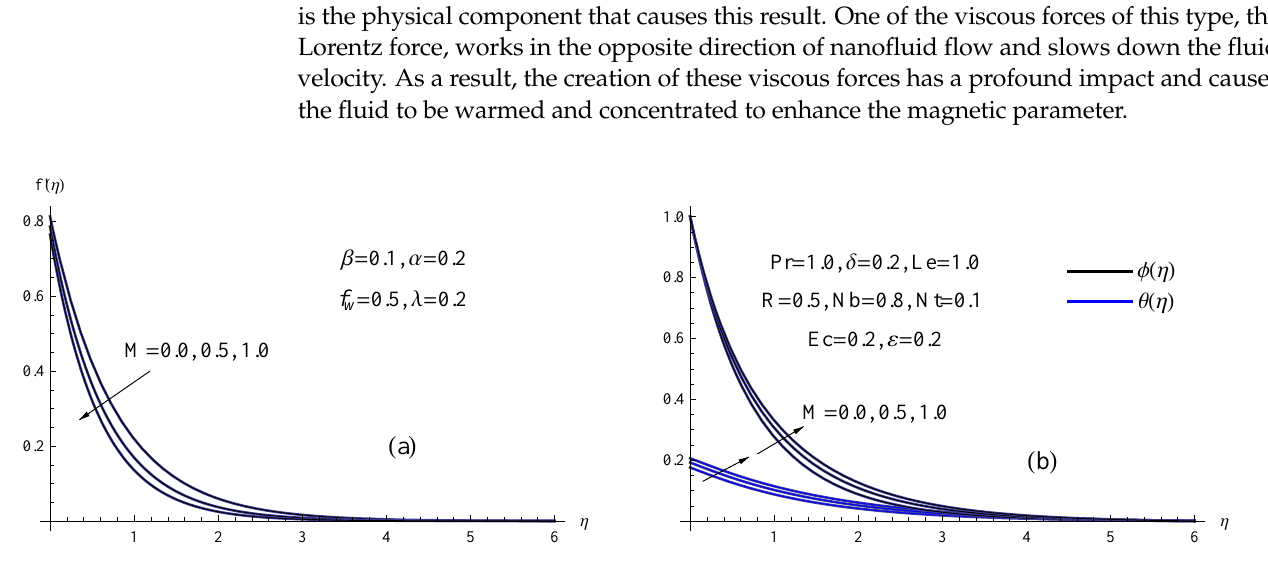
Figure 4. ( a ) The f (cid:48) ( η ) for chosen M , ( b ) θ ( η ) and φ ( η ) for chosen M . For various values of the viscosity parameter α , Figure 5 explains the demeanor of the velocity f (cid:48) ( η ) , temperature θ ( η ) and concentration φ ( η ) fields. The graphic shows that as the viscosity parameter climbs, the momentum boundary layer thickness and velocity field slow down. The essential duty of nanofluid viscosity, which mostly depends on temperature, is to promote mass and heat transfer rates within the boundary layer. As a result, it is evident that as the viscosity parameter improves, the concentration and temperature of nanofluid